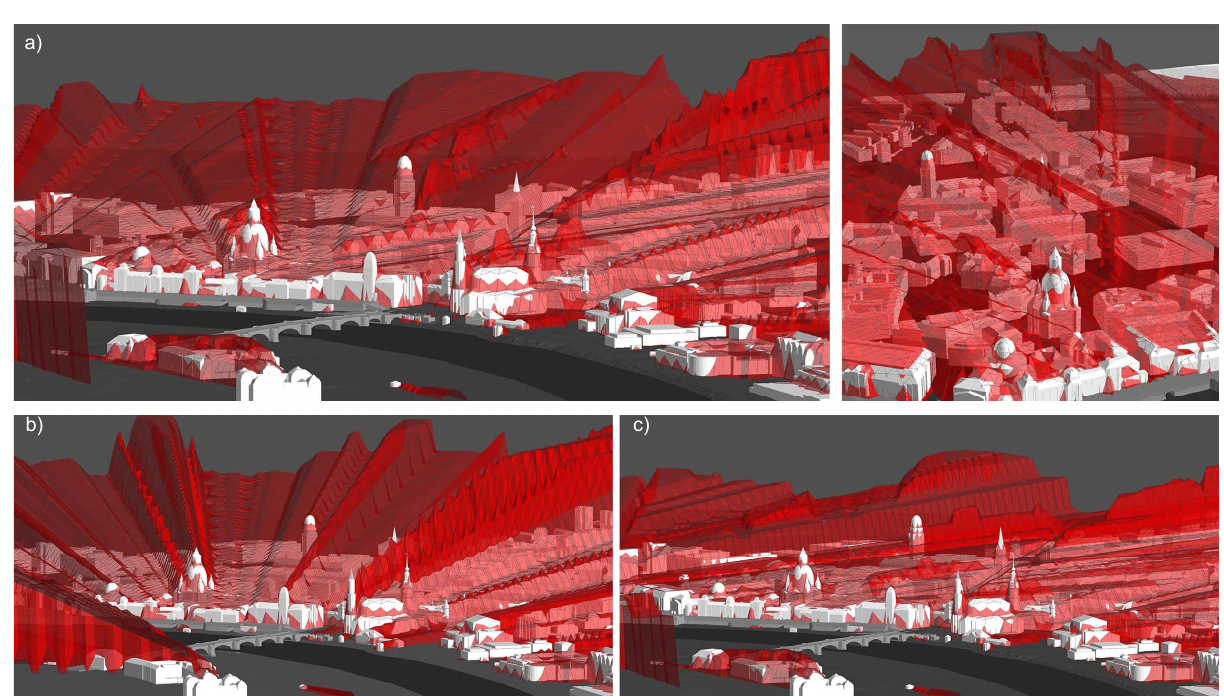
Figure 8. Comparison of VPS emulations for selected views of Dresden skyline seen from river: a) VPS for two view points; b) VPS for one view point (Canaletto